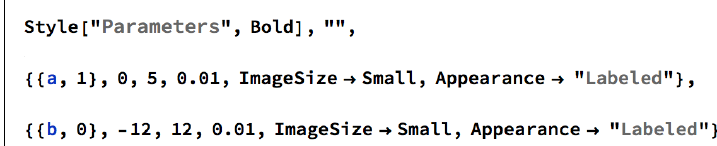
Figure 4. Code snippet of the PES(Linear)-Tool. This is part of the code that generates the range of values for the parameter a that run through the slider.